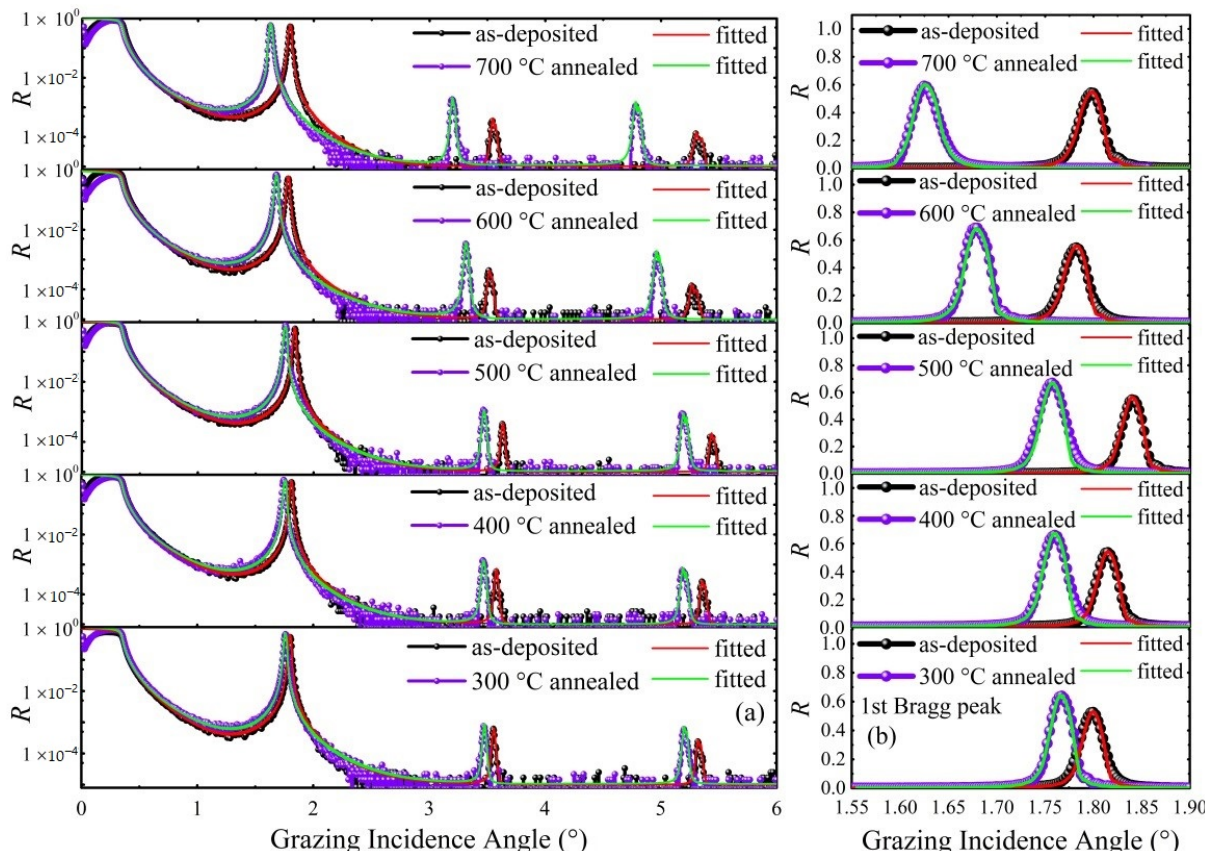
Figure 1. ( a ) GIXR measurements and ( b ) First-order Bragg peaks ( E = 8.04 keV) of Ru/C multilayers under different annealing. Table 1. Detailed fitting structural parameters of Ru/C multilayers measured before and after an- nealing.